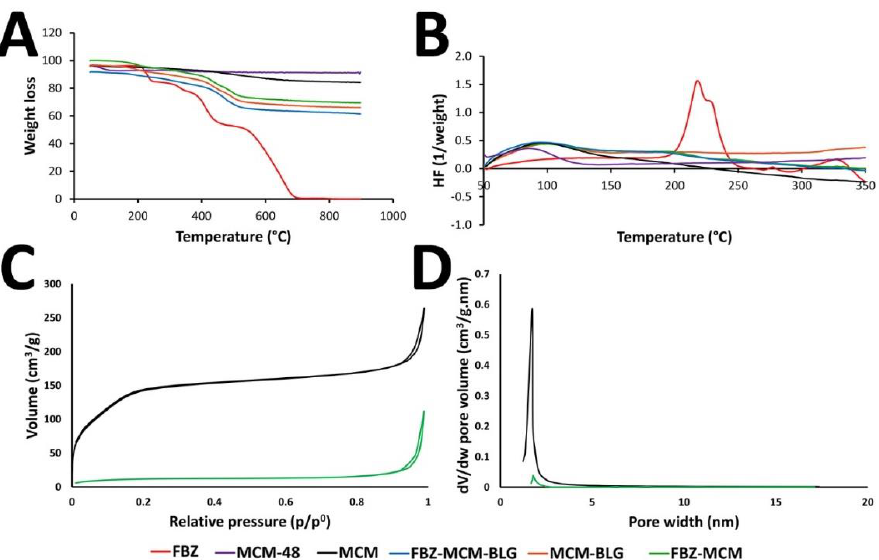
Figure 2. ( A ) TGA thermogram of FBZ, MCM-48, MCM, FBZ-MCM, MCM-BLG, and FBZ-MCM- BLG nanoparticles; ( B ) DSC thermogram of FBZ, MCM-48, MCM, FBZ-MCM, MCM-BLG, and FBZ-MCM-BLG nanoparticles; ( C ) N2 adsorption-desorption isotherms; and ( D ) pore size distributions of MCM and FBZ-MCM nanoparticles using the BET method.